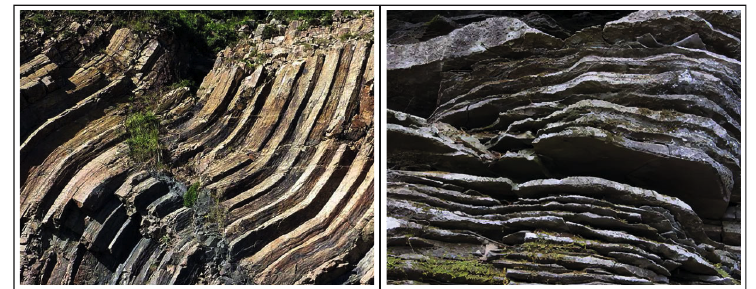
Figure 1: Natural transversely isotropic rock masses.